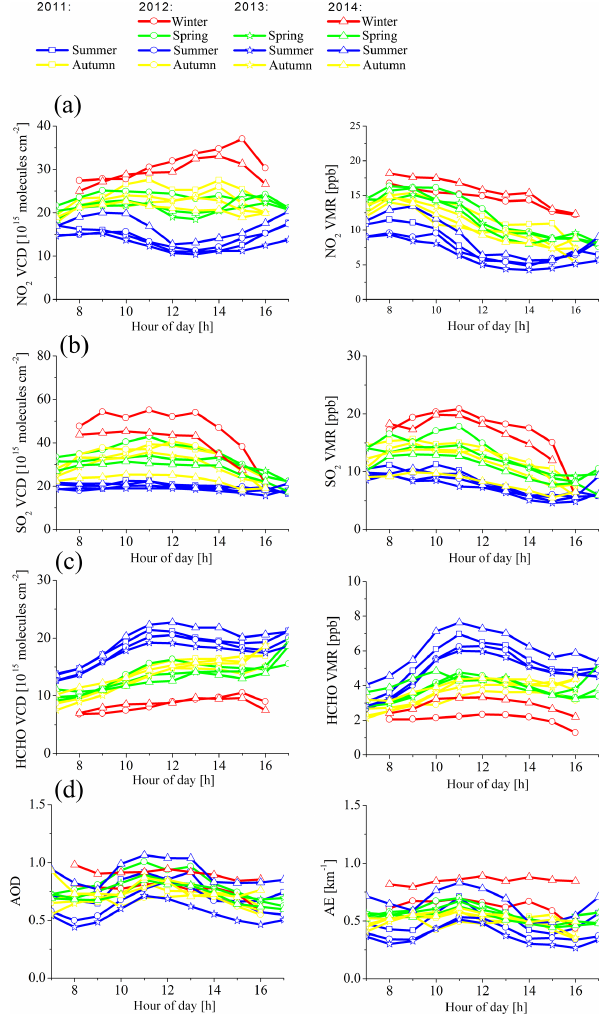
Figure 14. Seasonally averaged diurnal variations of trace gas VCDs and AOD (left panels) and near-surface values (right pan- els) of NO 2 (a) , SO 2 (b) , HCHO (c) and aerosols (d) from 2011 to